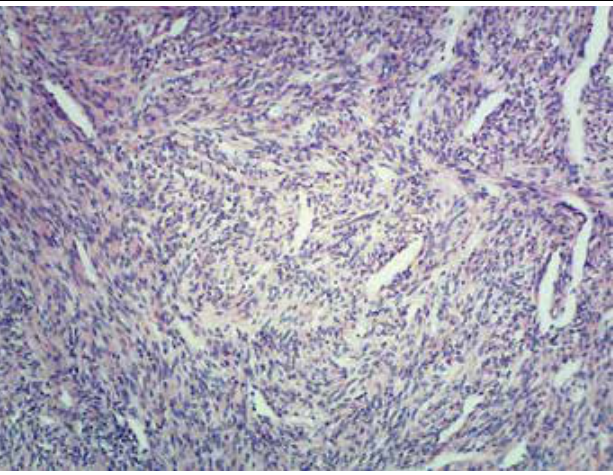
figuRE 2 − Mixed epithelial and stromal tumor: spindle cells arranged in short fascicles, hematoxylin-eosin, 200 × .